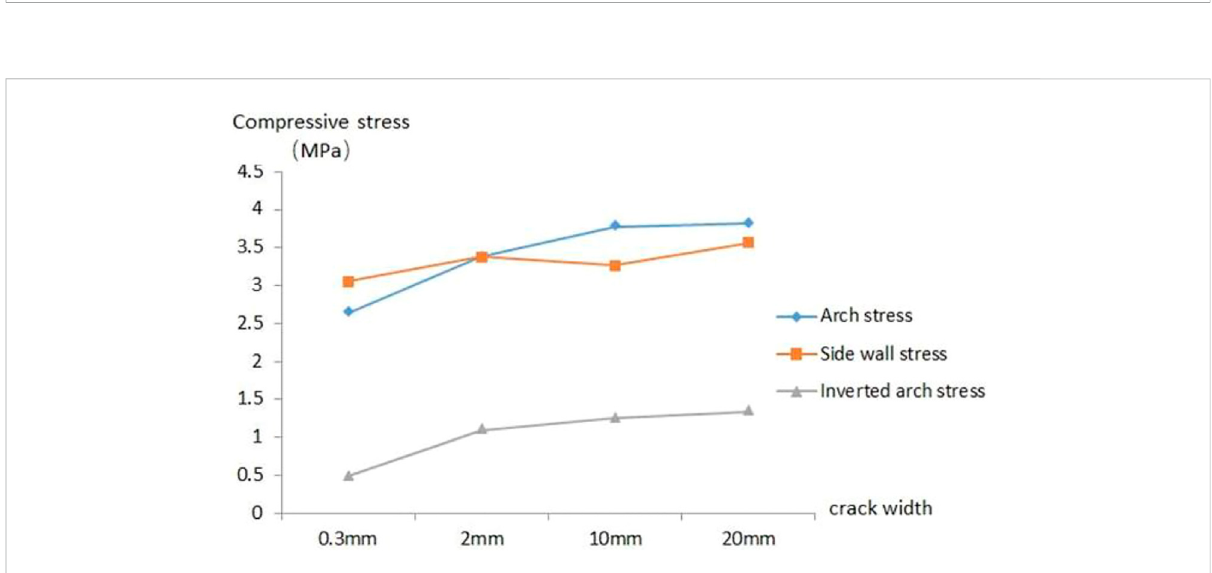
FIGURE 6 Stress variation diagram of main position of cracked lining of vault